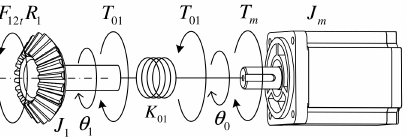
Figure 2. Motor and the driving wheel of the LSPR